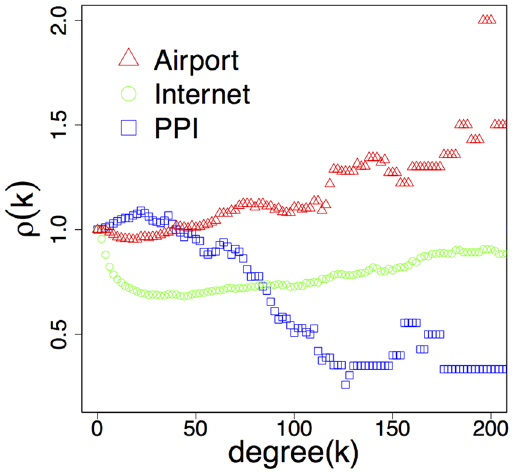
Figure 1. Illustration of the diverse rich club organization in real networks. The plot shows the normalized rich ( ) club coefficient ρ ( k ) as the function of degree k as: ρ φ = φ is the density of the subgraph G k of k k ( ) , where ( ) k φ k ( ) unc the network containing only the nodes with degree > k . The φ unc is the same for the maximally randomized version of the network conserving the degree distribution. One can see that the subgraph of hubs in the airport network possesses about 1.5 times more links than in the randomized version. On the contrary, the hubs in the PPI network have less than the half of the connections experienced in its randomized counterpart.